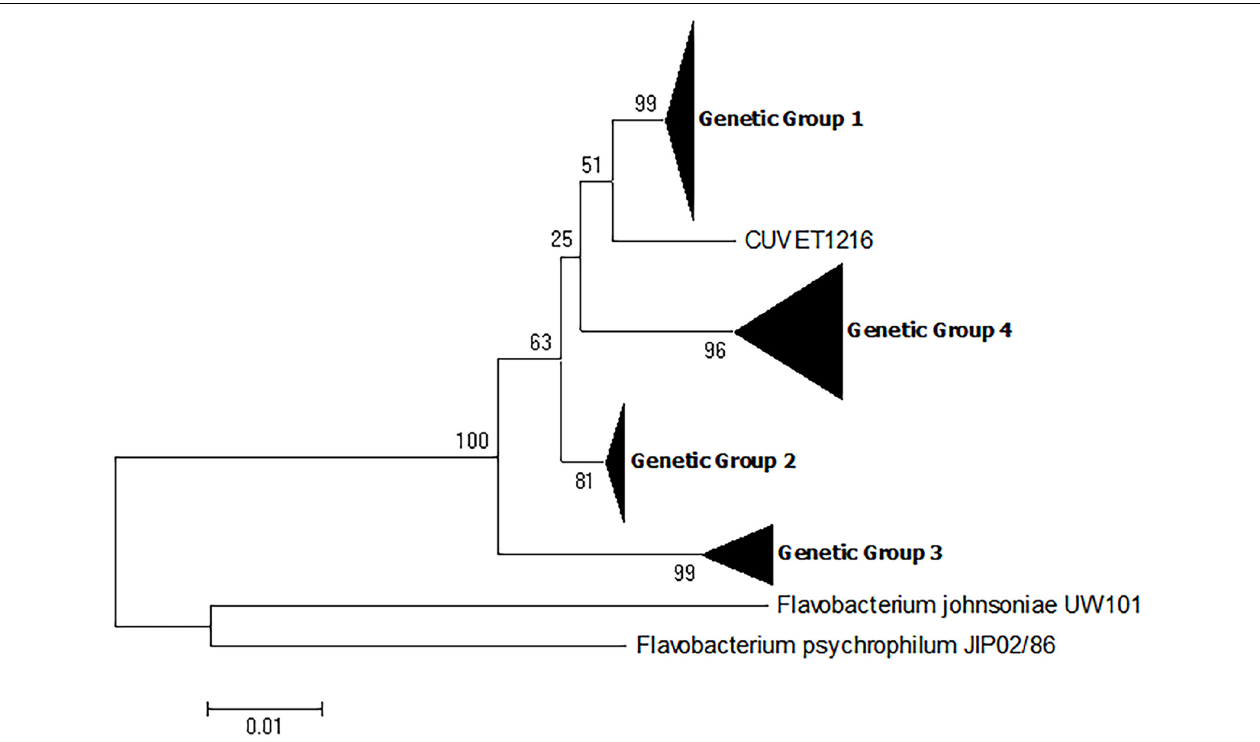
FIGURE 3 | Phylogenetic relationships based on 16S rRNA gene sequences of 140 isolates of Flavobacterium columnare . Relatedness was inferred using the maximum likelihood method based upon the Kimura 2-parameter model (K2+G) and rooted with F. johnsoniae and F. psychrophilum . The percentage of trees in which the associated sequences clustered together in the bootstrap test (1,000 replicates) is shown next to the branches. The analysis involved 142 nucleotide sequences, all positions containing gaps and missing data were eliminated, and there were a total of 1,061 positions in the final dataset. See Supplementary Table 1 for individual isolates falling into each genetic